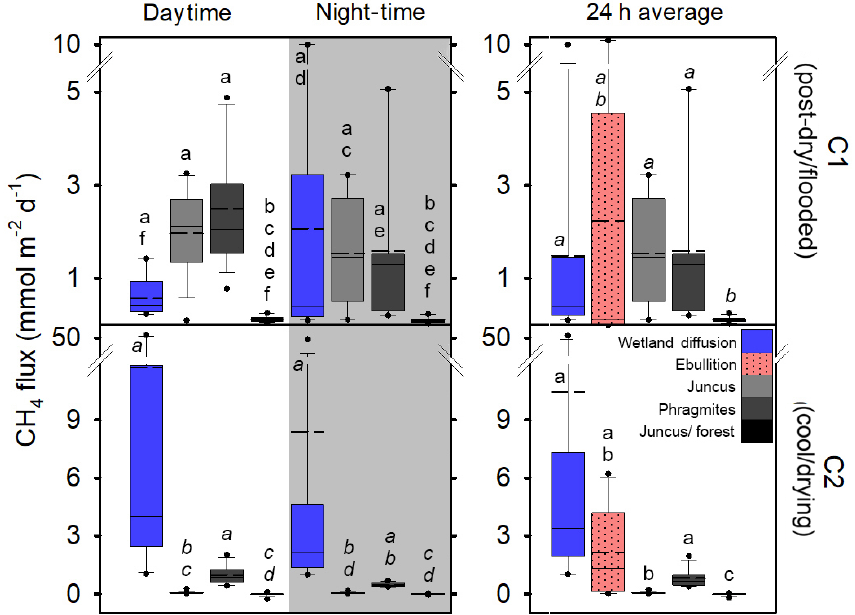
Figure 5. Fluxes of CH 4 from diel sampling and ebullition over two campaigns from the permanent wetland and adjacent 24h time series of the seasonal wetland vegetation types. Note: diffusive fluxes during C2 include chambers featuring lilies, dashed line represents the average, solid line represents the median, and dots represent the 5th and 95th percentiles. Letters show groups that did not differ significantly ( p >0.05) using ANOVA on ranks and Dunn’s pairwise comparisons within each